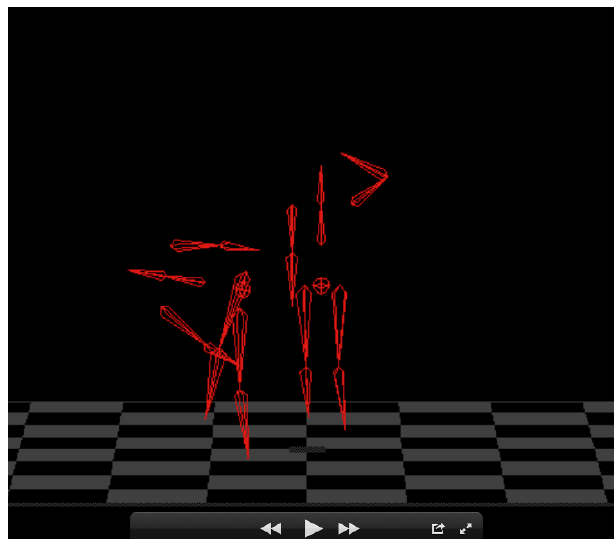
Figure 6. Choreographer Working with Kinect, Integrate and DanceForms